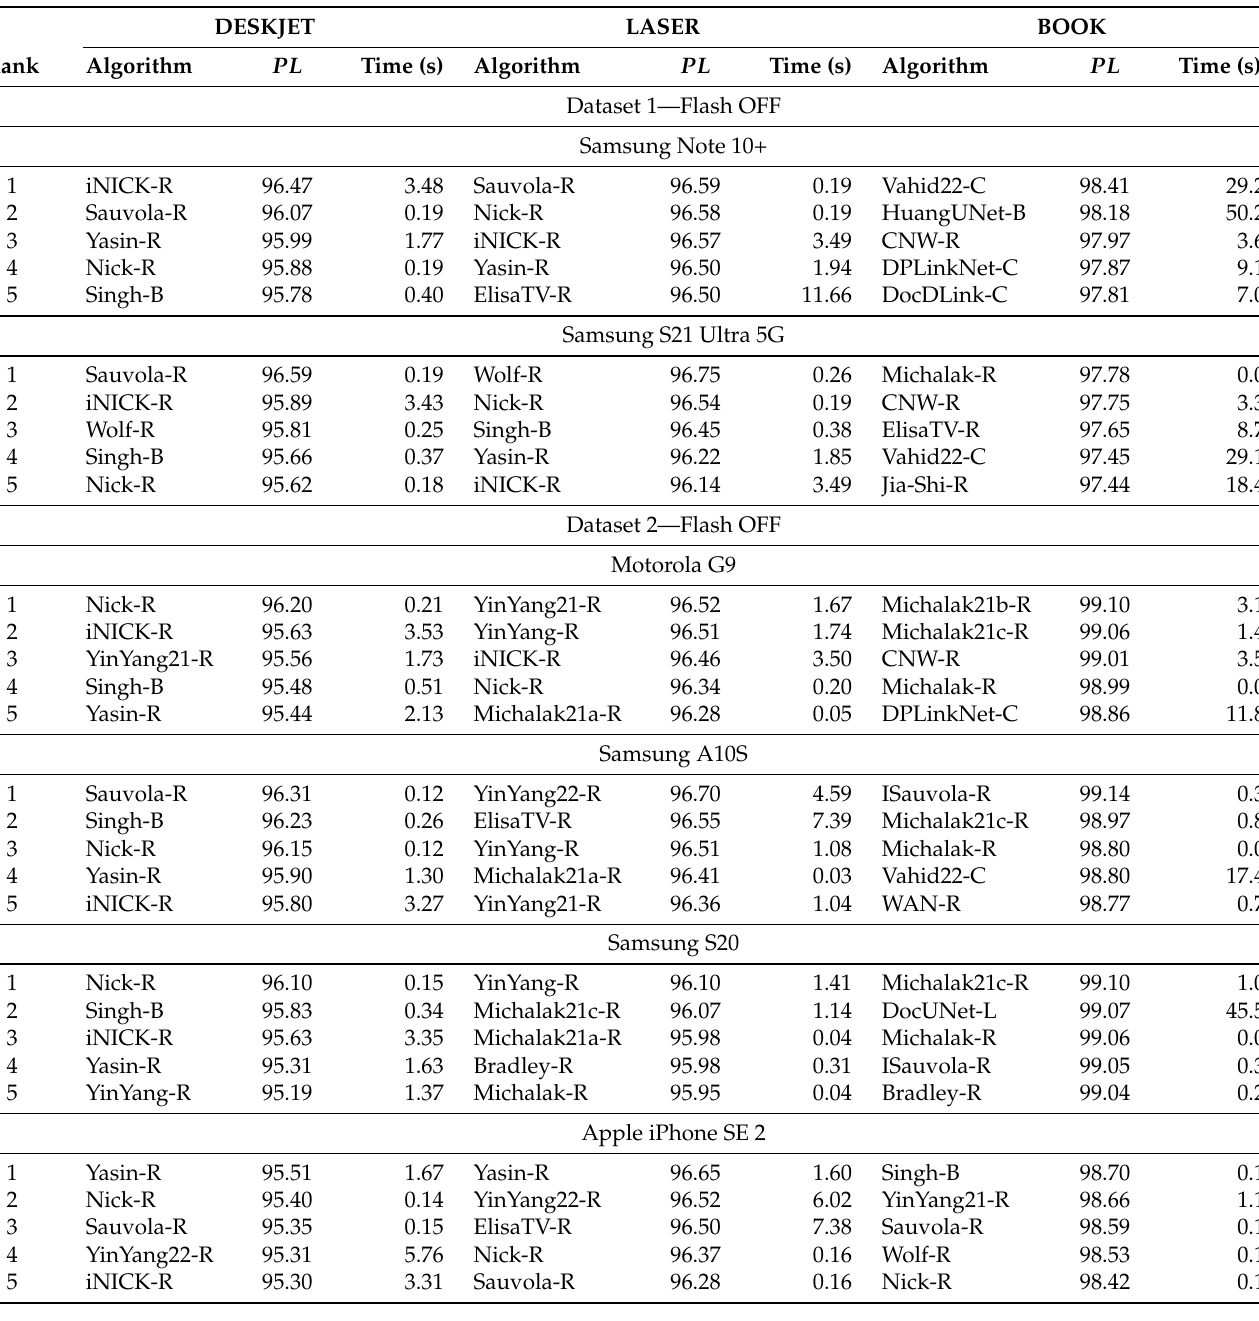
Table 5. Summary of results with PL measure and flash OFF sorted according to the quality-time